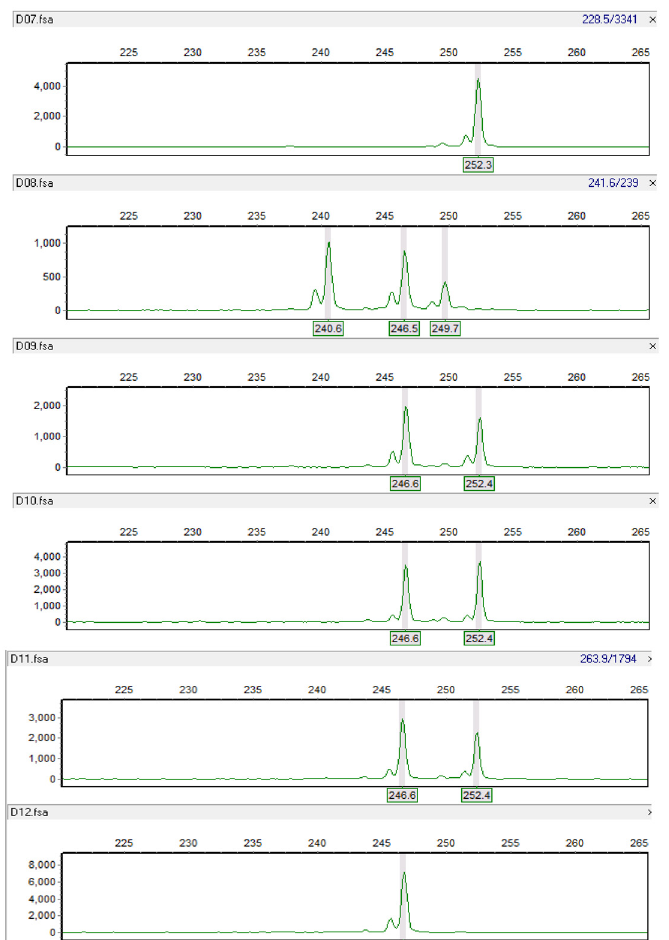
Fig 1. An example of amplification profiles of SSR marker